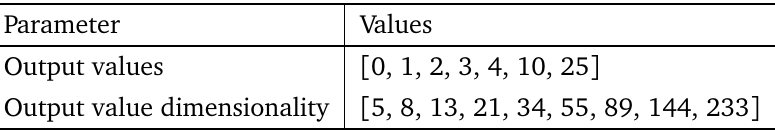
Table 17: Network parameters of the Deep SVDD